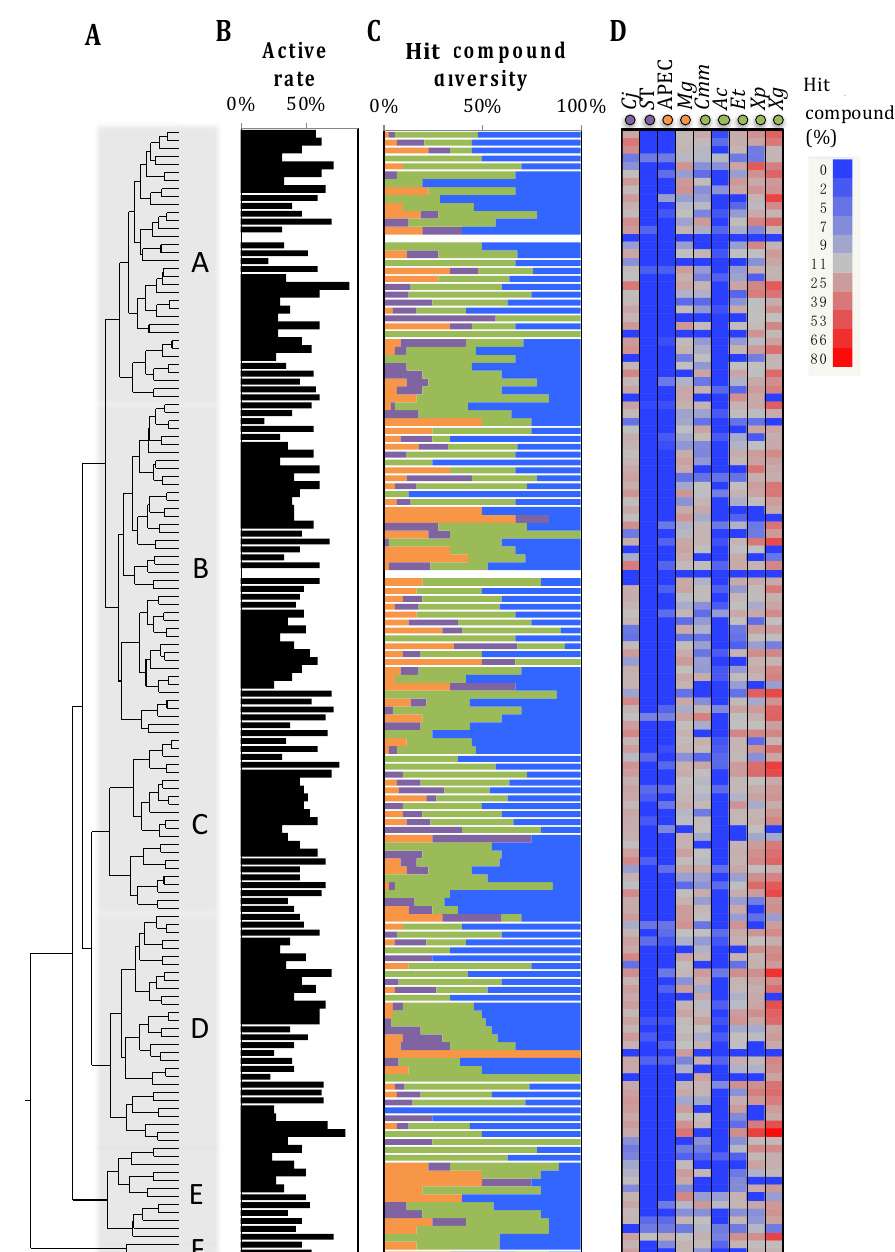
Figure 3. Analyses of the pre-selected small molecule (SM) library based on the two-dimension Tanimoto scoring system. ( A ) Chemical structure diversity of the SM library based on two-dimension Tanimoto scoring (PubChem database) combined with a hierarchical clustering method. The SM (4182 SM) were grouped into 141 clusters that contain between 4 and 144 SM with high chemical structure similarities (Bartlett’s test; p < 0.01). Cluster A: 188 SM; B: 252 SM; C: 727 SM; D: 802 SM; E: 231 SM; F: 43 SM. ( B ) Proportion of hit compounds within each cluster. ( C ) Activity spectrum of the hits within each cluster. Green, orange, and purple bars: hits specific to plant, animal, or human/foodborne pathogens, respectively at a given SM concentration and growing condition (Table 1); blue bar: hits effective against more than one pathogen category. ( D ) Proportion of the hits per pathogen ( n = 9). The cell color (from blue to red) is proportional to the number of hits for